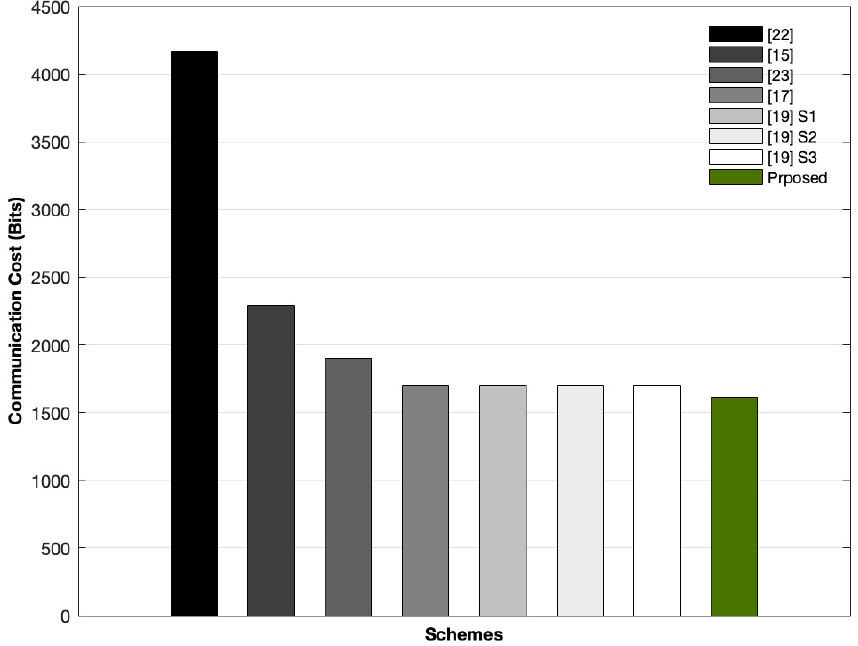
Figure 5. Total communication cost.